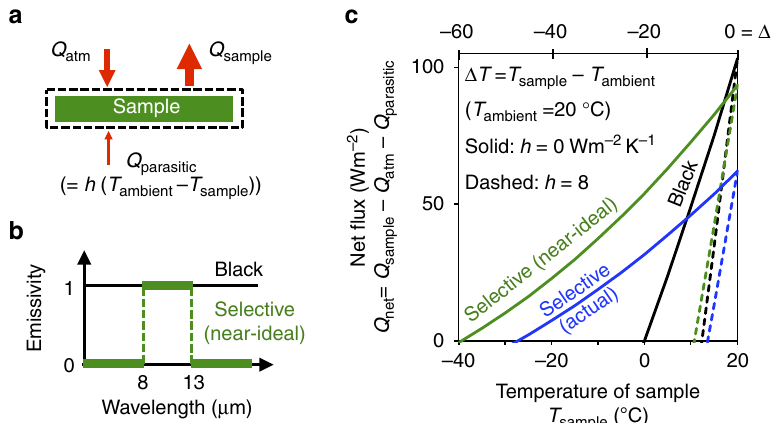
Figure 1 | Theoretical analysis. ( a ) Energy balance applied to the radiative emitter (dashed line). The net flux ( Q net ) is determined by the outgoing flux from the emission of the sample ( Q sample ), and the two incoming fluxes from the emission of the atmosphere ( Q atm ) and the parasitic heat losses ( Q parasitic ) characterized by a heat transfer coefficient h . ( b ) Three emitters are considered: a black emitter (black line), a near-ideal selective emitter (green line) and the actual selective emitter (blue line in Fig. 3b) of this work. ( c ) Net flux ( Q net ) as a function of the temperature of the sample ( T sample ). Note that the calculation is based on a typical atmospheric transmittance at Stanford in winter (grey line in Fig. 3b). The key parameter is the steady-state temperature corresponding to Q net ¼ 0. The analysis highlights the two key ingredients to achieve large temperature reduction below ambient: selectivity of the emitter and minimization of the parasitic heat loss. The performance of the actual selective emitter (blue) designed and tested in this work is also predicted.